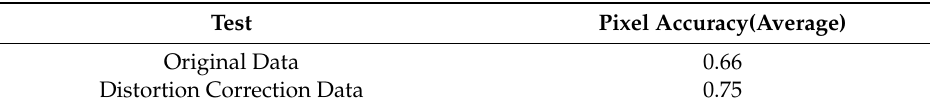
Table 12. Pixel accuracy of original and distortion correction data.